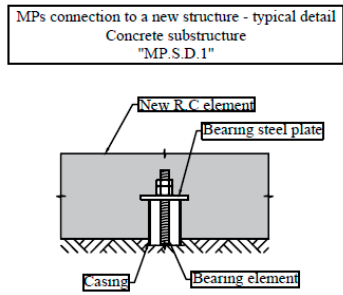
Figure 10. Base isolator system attachment to steel superstructure and concrete substructure—typical detail (after [20,32,33]).